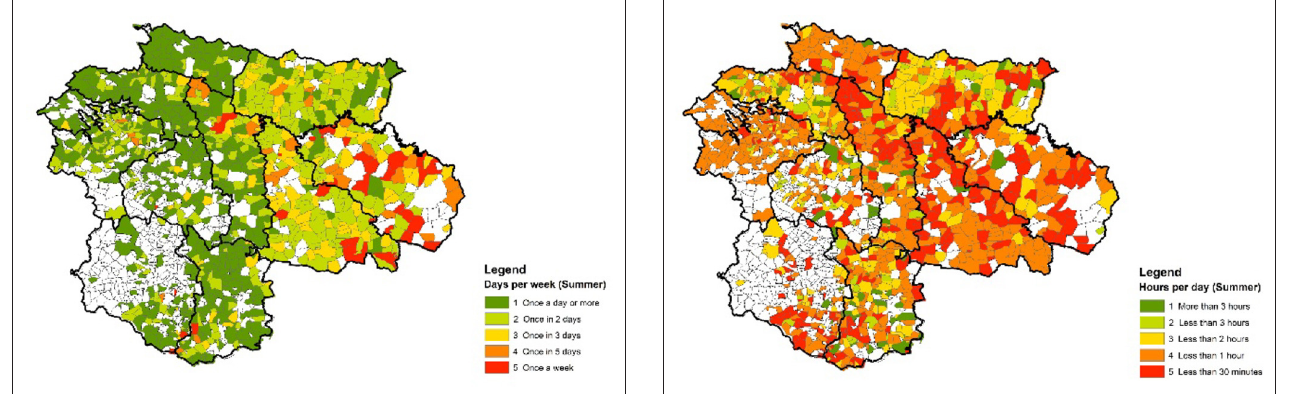
FIGURE 4 | Days of PWS per week (summer). FIGURE 5 | Hours of PWS per day